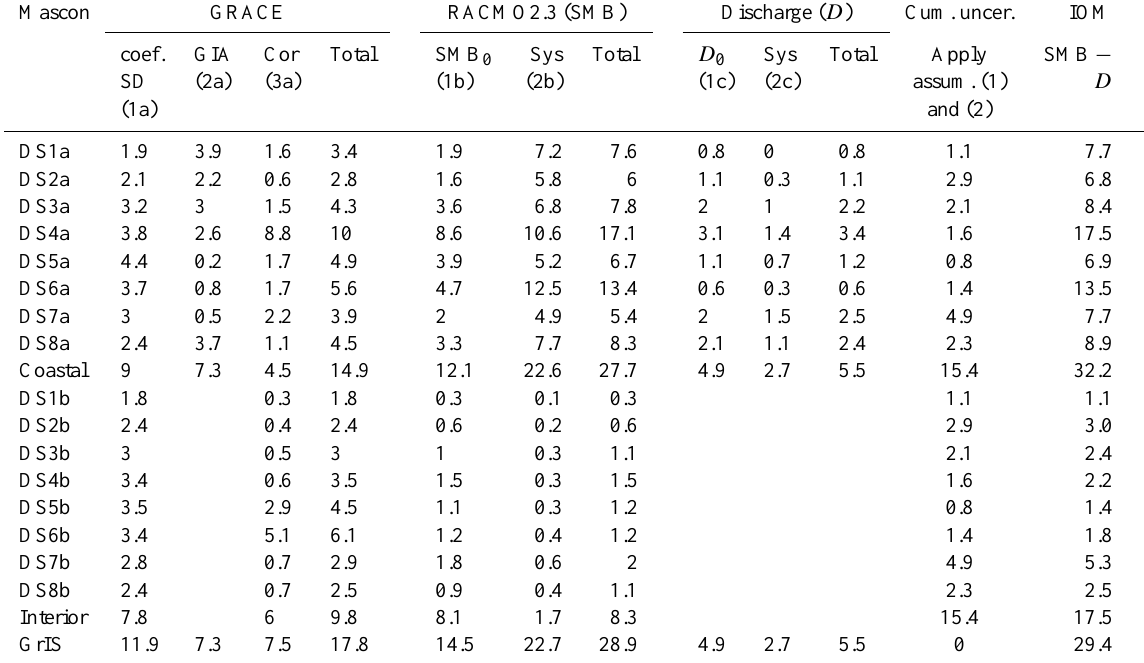
Table A2. The uncertainties associated with the regional mass change rates. For the GRACE-inferred regional solutions, “coef. SD” refers to the errors due to the standard deviations in the CSR RL05 spherical coefficients, “GIA” refers to the errors obtained from comparing 11 GIA models. Note that the GIA uncertainties in the interior GrIS are all close to 0 and are therefore negligible. In the column with the header “cor” we show the uncertainties which are caused by the approximation error correction. For SMB and D trend estimations, the uncertainties consist of the reference SMB 0 and D 0 error (“SMB 0 ” and “ D 0 ”) and the systematic errors in RACMO2.3 model and in the discharge estimations (“sys”). The column titled “cum. uncer.” refers to uncertainties using the assumptions (1) and (2); see Sect. 3.2 for details. The highlighted columns show the total uncertainties of the linear fit of the GRACE and IOM mass